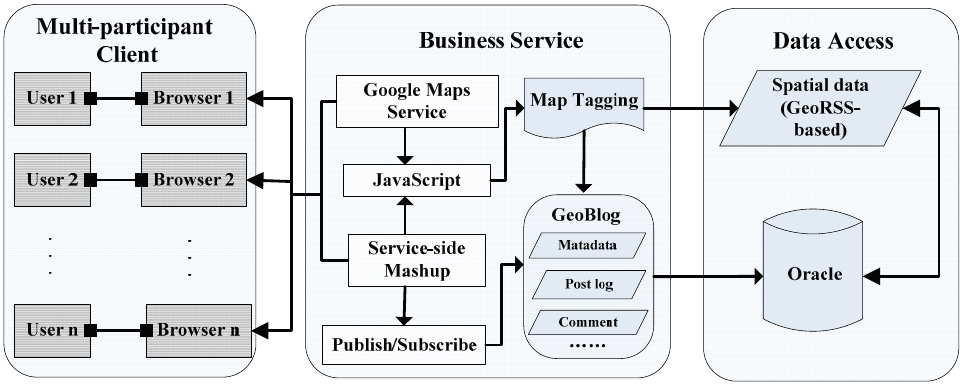
Figure 6. The general architecture of the tagging